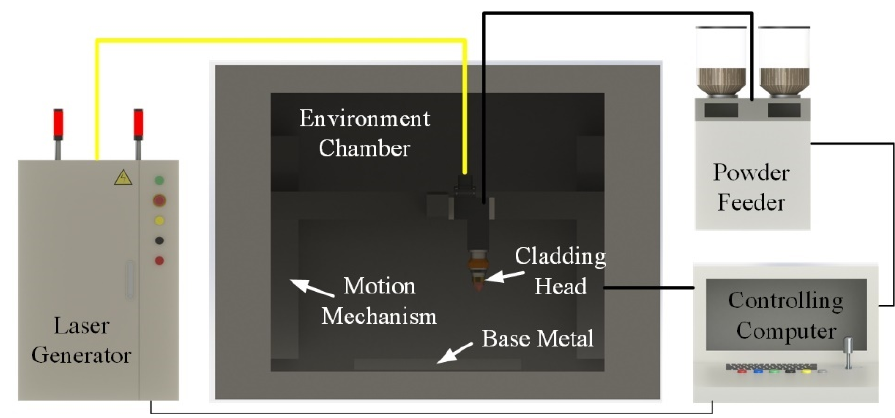
Figure 2. Schematic diagram of laser melting deposition (LMD) system.